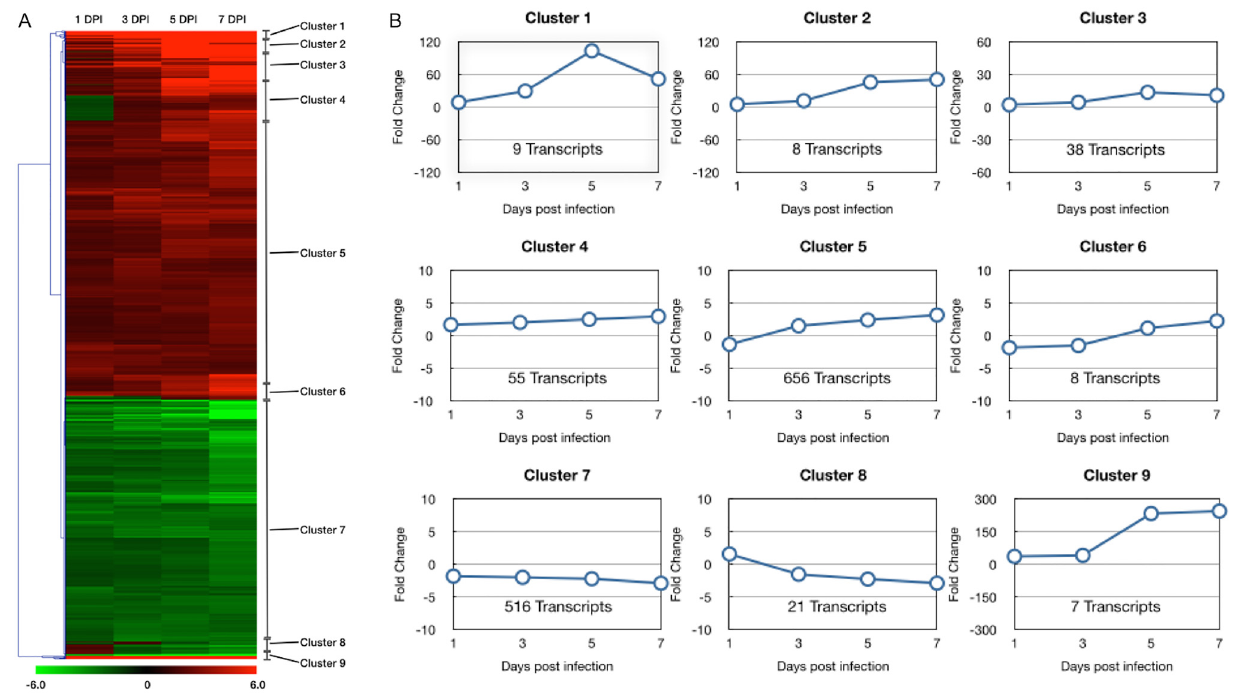
Fig 3. Hierarchical clustering (A) and k-means clustering (B) of differentially expressed transcripts of REV infected CEFs at different post-infection time points. Expression profiles of differentially expressed transcripts with p < 0.05 at all time points and fold changes > +/- 2 at one or more time points. These significantly regulated transcripts were clustered into 9 distinct groups having similar expression response profiles over the time course of REV